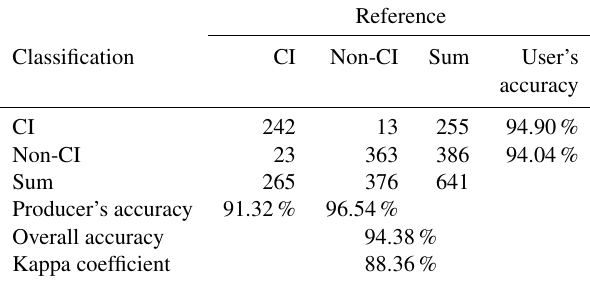
Table 5. Assessment of the RF model for CI detection using the test data.